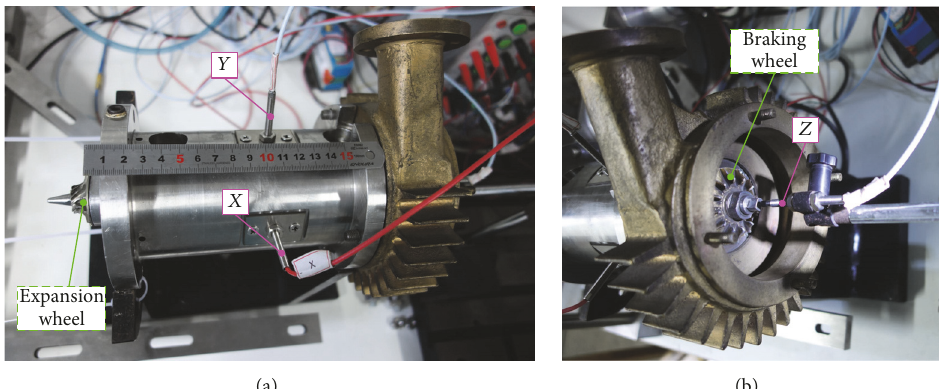
Figure 4: Real picture of high pressure gas driven turboexpander test rig: (a) upper view; (b) side view (with expansion volute